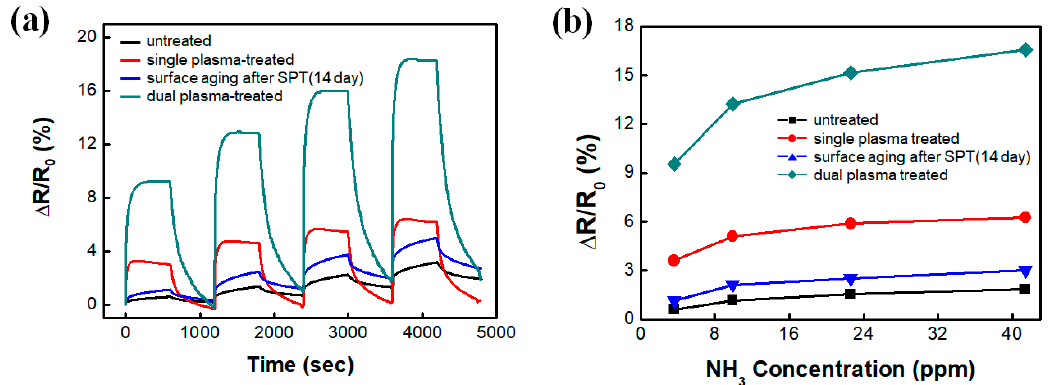
Figure 5. ( a ) Responses and ( b ) calibration curves of the SPT- and DPT-SWCNT sensors for monitoring NH 3 gas.